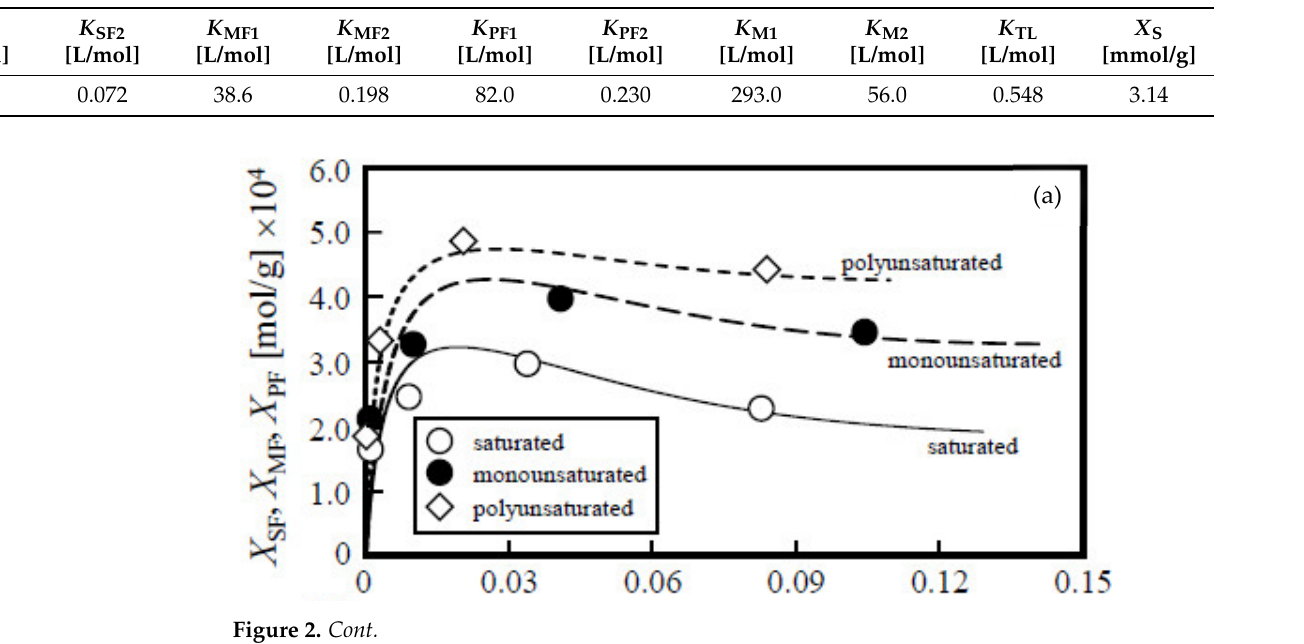
Table 5. Estimated adsorption equilibrium constants for the categorized FAMEs and the saturated adsorption density.